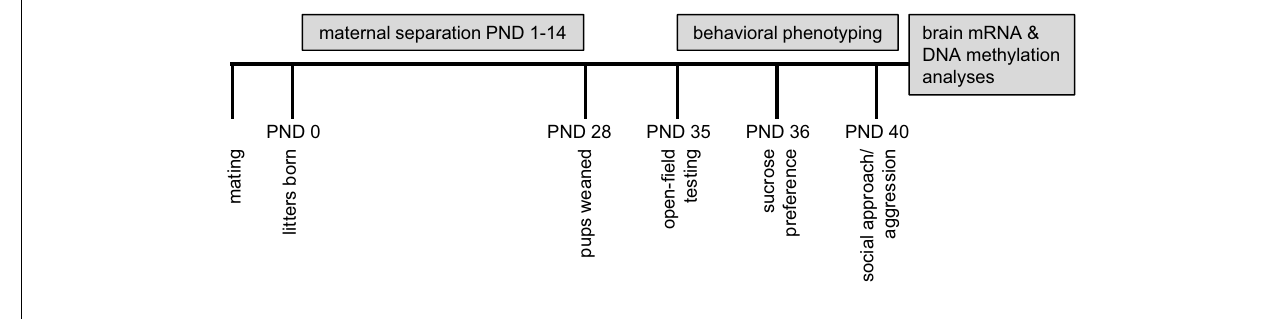
FIGURE 1 | Summary of experimental design